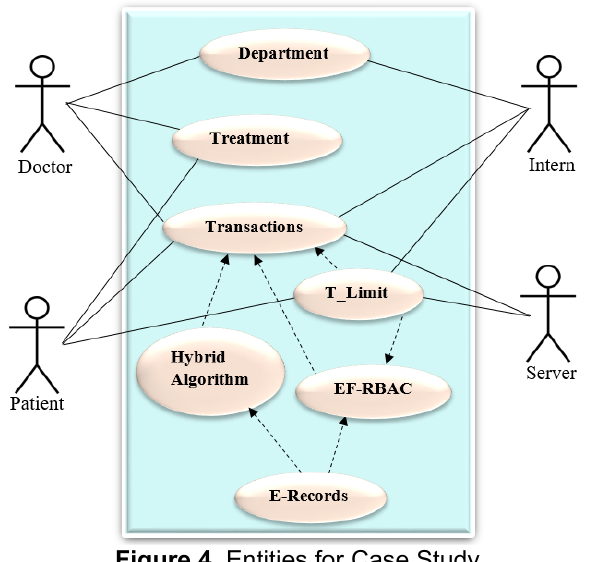
Figure 4. Entities for Case